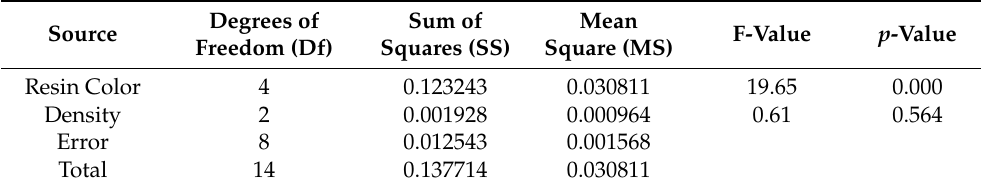
Table 4. Analysis of variance for length deviation.